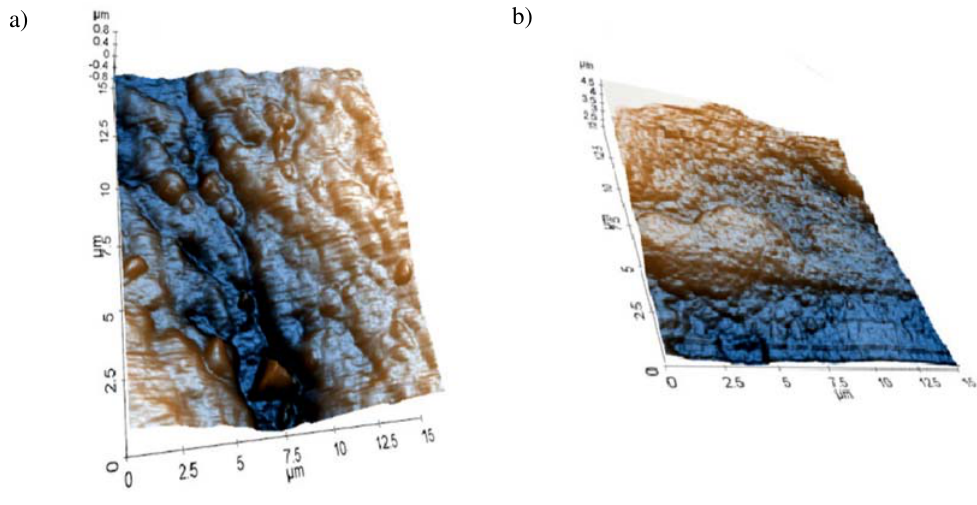
Figure 5. AFM image of TiO